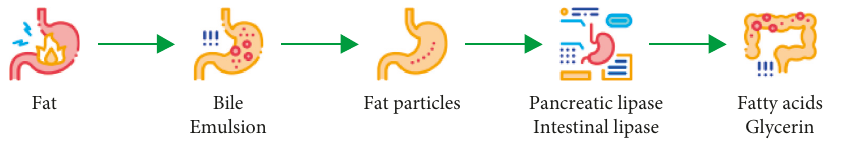
Figure 1: Functional drink